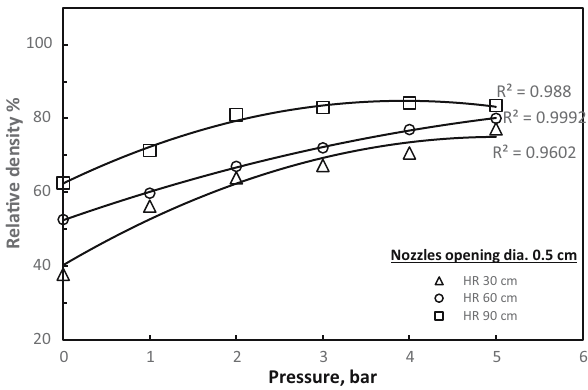
Figure 5: Variation of RD, TAP, and HF for nozzle size of 0.5 cm.